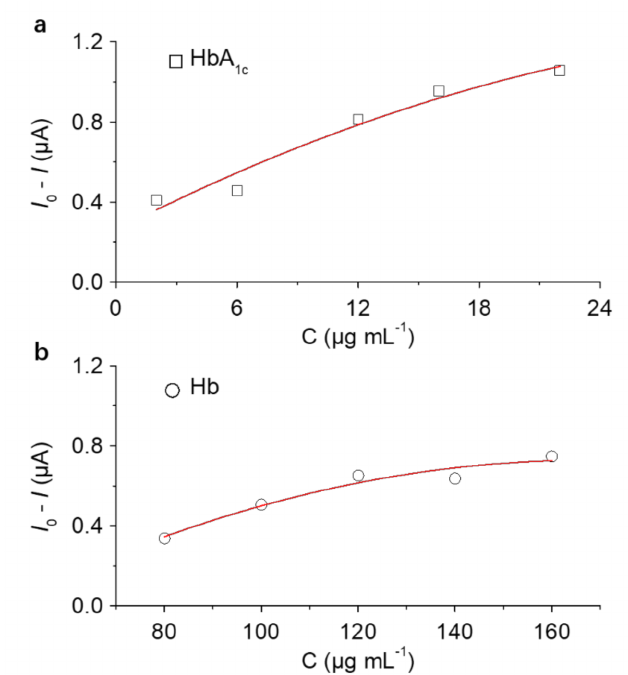
Figure 4. ( a ) Plotting the current changes of aptasensor 1 with increasing HbA 1c , and ( b ) plotting the current changes of aptasensor 2 with increasing Hb, where I and I 0 are the current intensity of an aptasensor in the presence and absence of protein analyte,